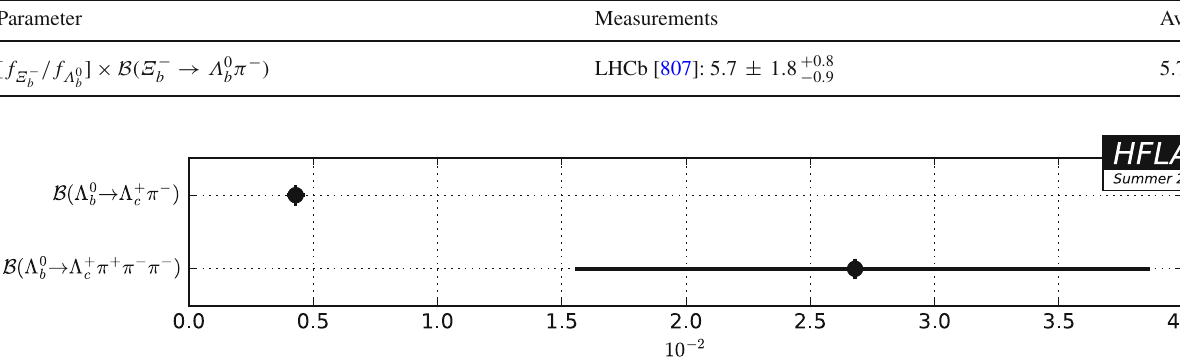
Table 217 Ξ b decay rates [ 10 − 4 ]